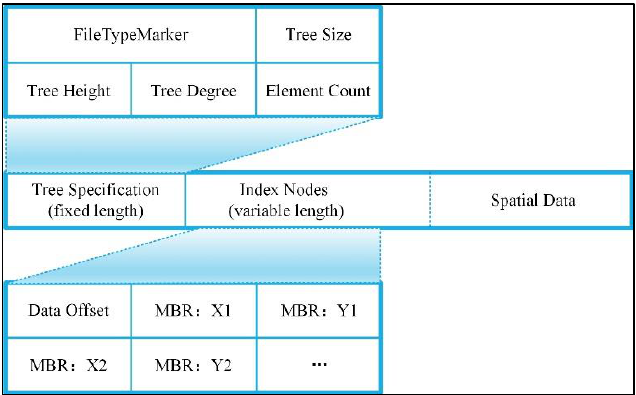
Figure 3. R-tree Local Index